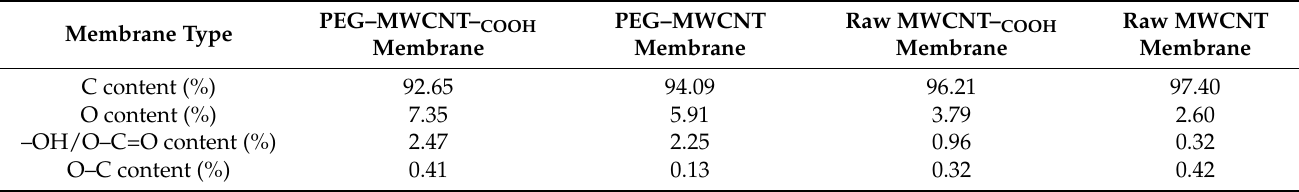
Table 1. Quantitative analysis of C and O elements by